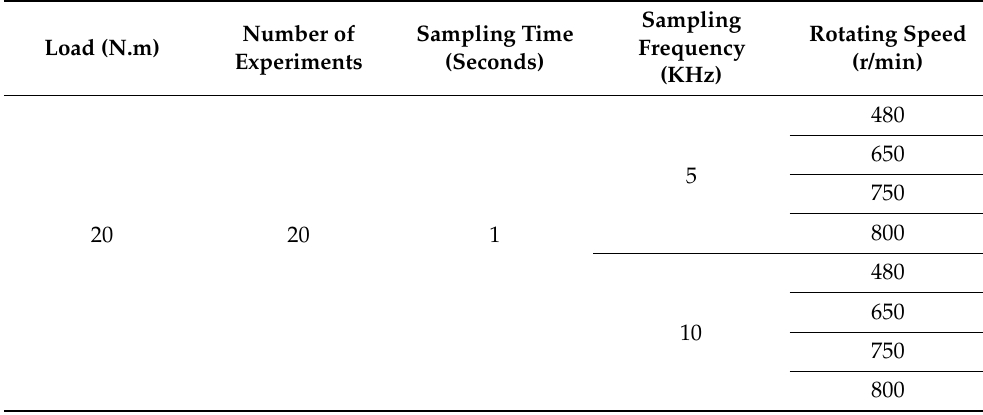
Table 4. Experimental gear example